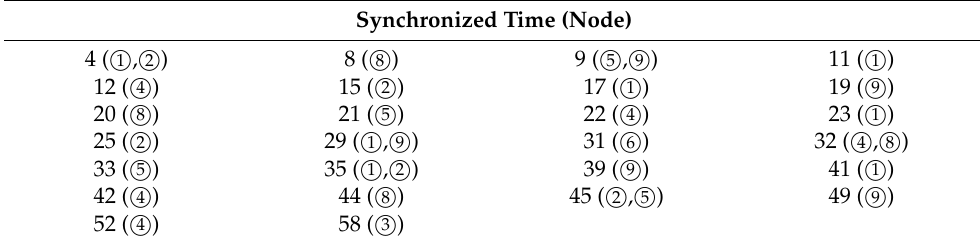
Table 6. Synchronized timetable for